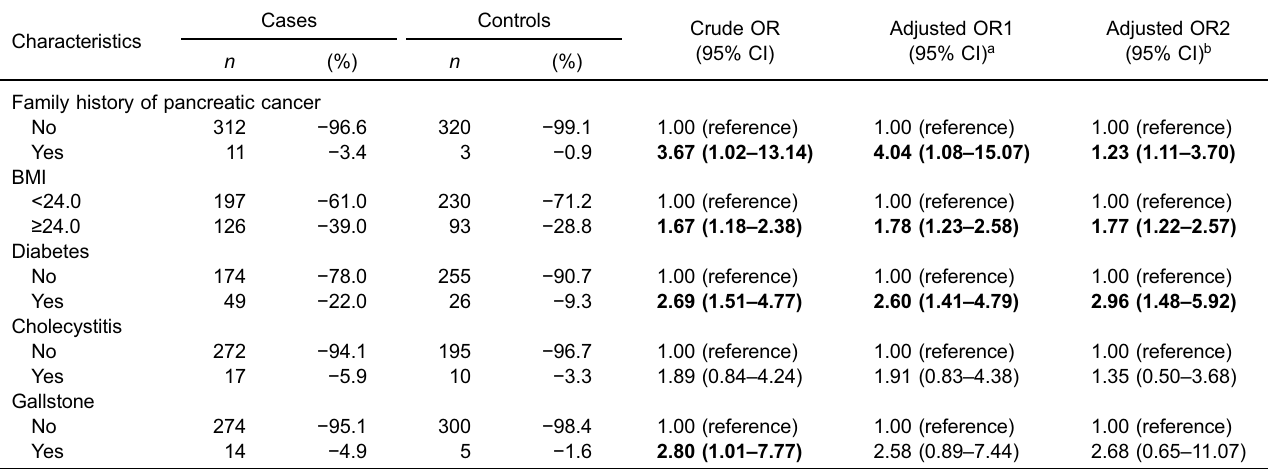
Table 3. Characteristics of patients associated with risk of pancreatic cancer